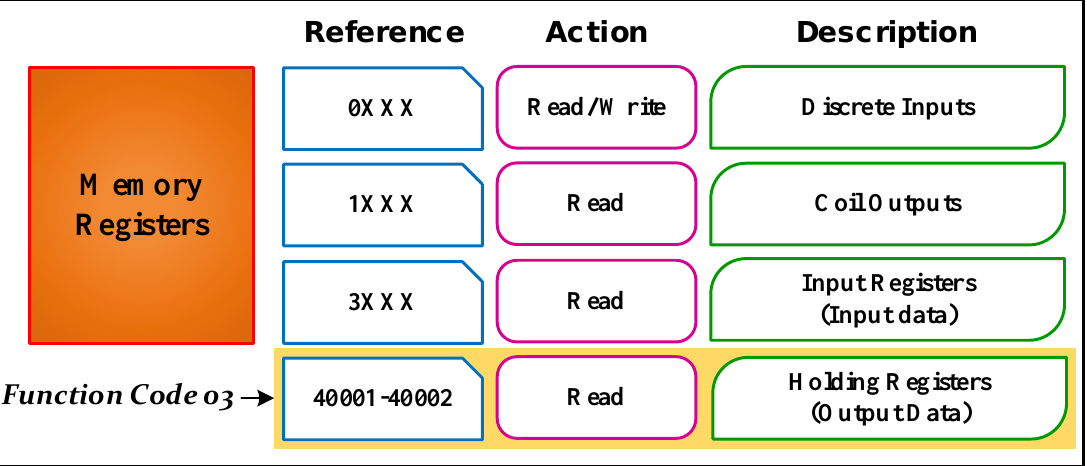
Figure 8. Representation of MODBUS data structure.